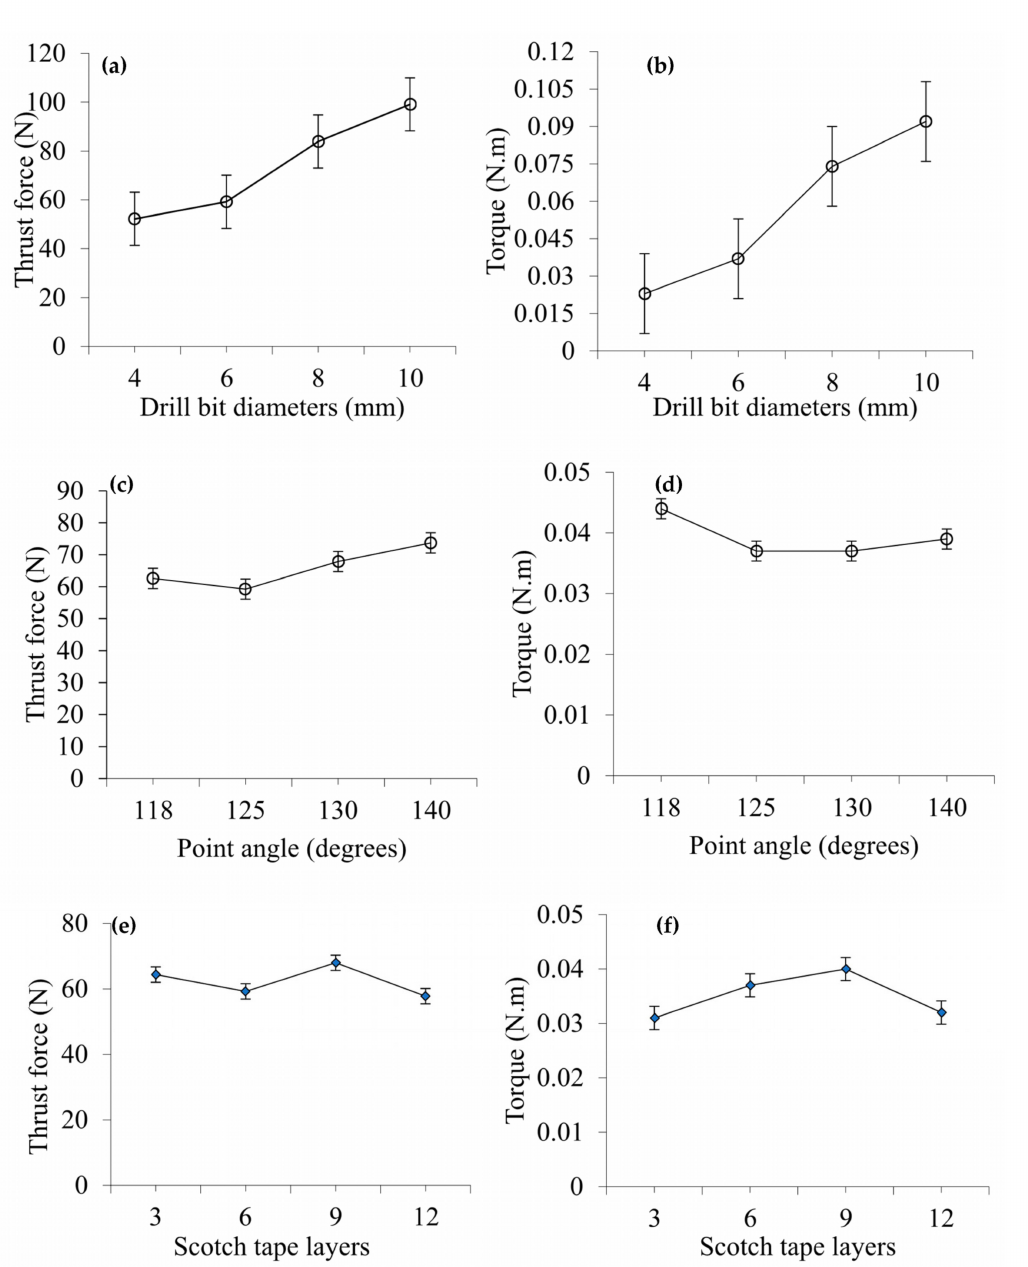
Figure 2. ( a , b ) Effect of drill bit diameters on thrust force and torque at point angle of 125 ◦ , 6 Scotch tape layers, spindle speed of 2250 rpm, and feed rate of 0.11 mm/rev, ( c , d ) Effect of point angle on thrust force and torque at drill bit diameter of 6 mm, 6 Scotch tape layers, spindle speed of 2250 rpm, and feed rate of 0.11 mm/rev, ( e , f ) Effect of Scotch tape layers on thrust force and torque at drill bit diameter of 6 mm, point angle of 125 ◦ , spindle speed of 2250 rpm, and feed rate of 0.11